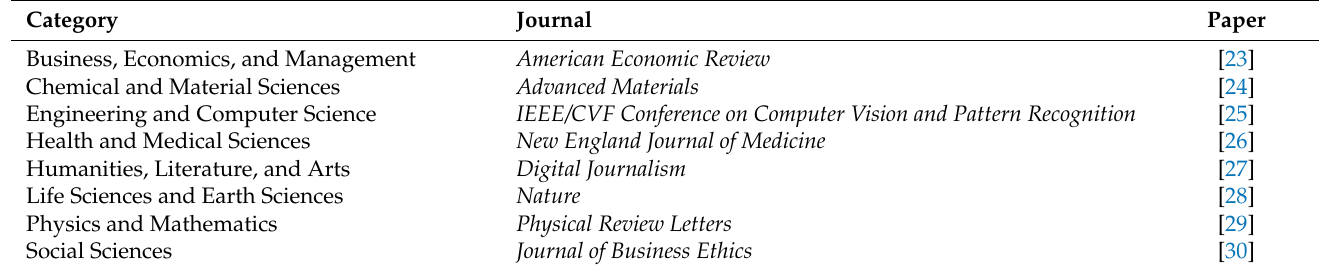
Table 3. The sample of papers whose study aims are illustrated based on the universal PICO scheme; the research categories are taken from Google Scholar Metrics